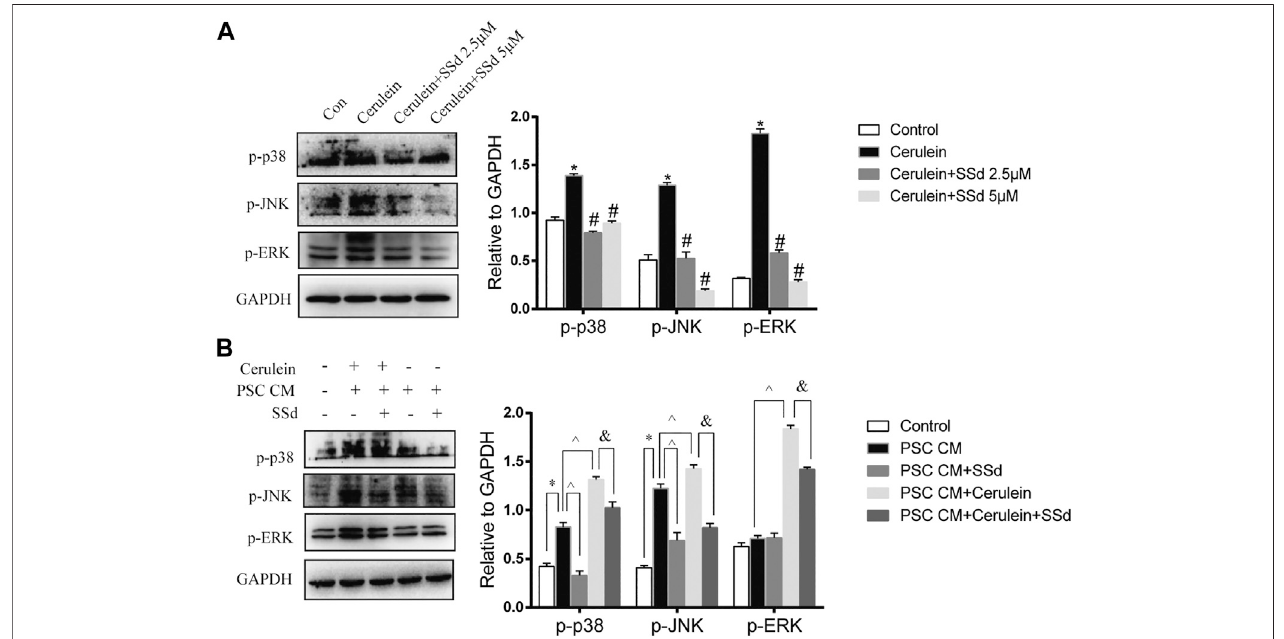
FIGURE 6 | Effect of SSd on AR42J apoptosis and in fl ammation through the MAPK pathway. (A) Western blot analysis of p-JNK, p-ERK 1/2, and p-p38 MAPK. AR42J were pre-treated with cerulein 10 nM for 1h, then incubated with or without 5 μ M or 10 μ M SSd for 24 h. (B) Western blot analysis of p-JNK, p-ERK 1/2, and p-p38 MAPK. AR42J cells were pre-treated with PSCs-CM with 5 μ M SSd or 10 nM cerulein or 10 nM cerulein and 5 μ M SSd for 24 h. Data are shown as the mean ± SEM of at least three independent experiments. (* p < 0.05 compared with the control group, # p < 0.05 compared with the cerulein induced group, ^ p < 0.05 compared with the PSCs-CM group, and p < 0.05 compared with PSCs-CM + cerulein